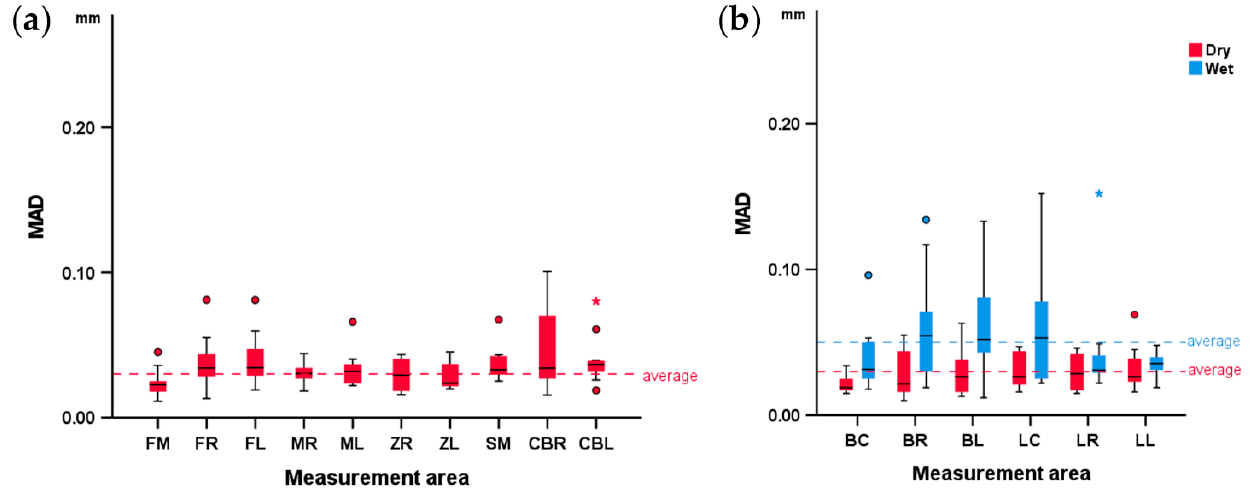
Figure 4. Box plots showing the scanner reproducibility at each measurement area in ( a ) dry conditions at the skulls and ( b ) in dry and wet conditions at the mandibles. MAD: mean absolute distance. Skull: forehead left (FL), right (FR), and middle (FM), maxilla left (ML) and right (MR), zygomatic bone left (ZL) and right (ZR), anterior cranial base left (ACL) and right (ACR), and sphenoid bone middle (SM). Mandible: buccal left (BL), right (BR), and center (BC) and lingual left (LL), right (LR), and center (LC).